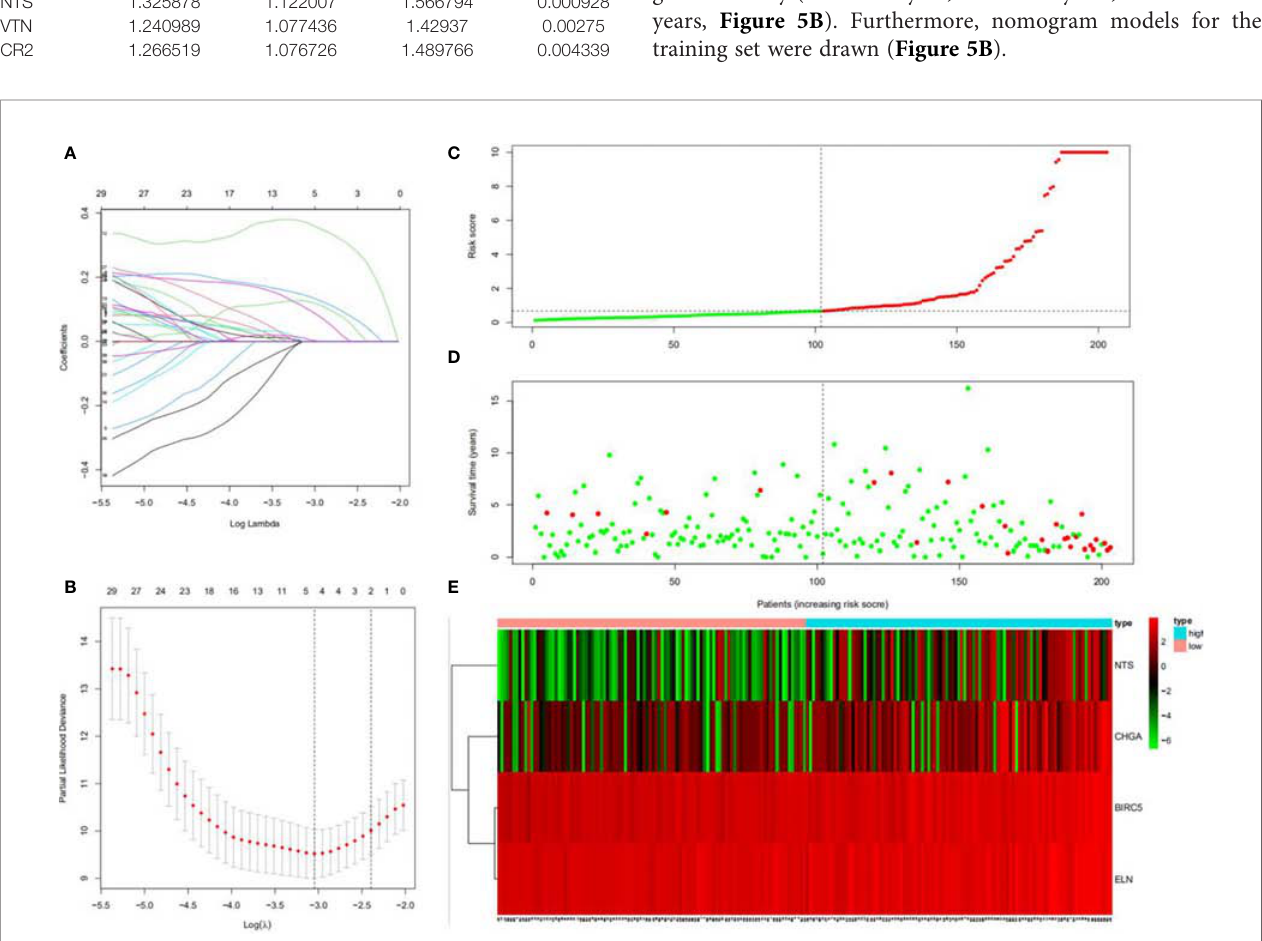
FIGURE 2 | Construction of the hub DEGs and risk score prognostic value. (A, B) The determination of the number of factors by the LASSO analysis; (C) the distribution of risk score patients; (D) the survival state of patients; (E) a heatmap of hub DEGs in the training set.